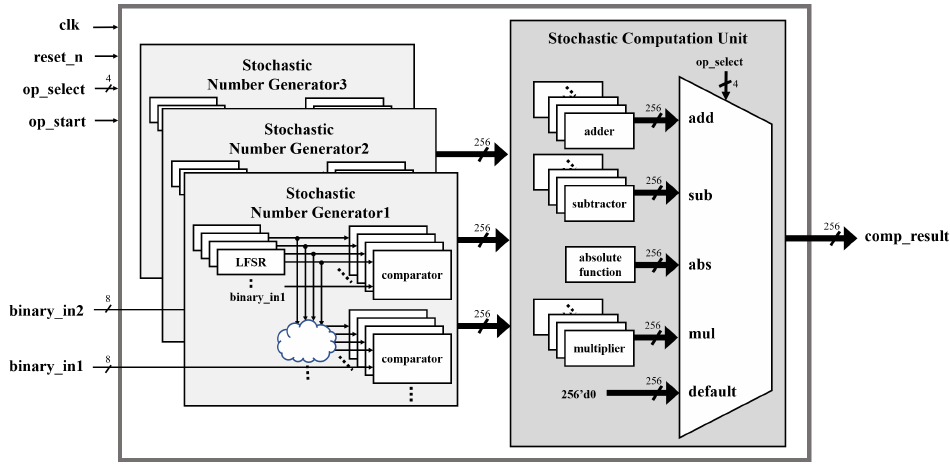
Figure 13. Architecture applying shared LFSR.